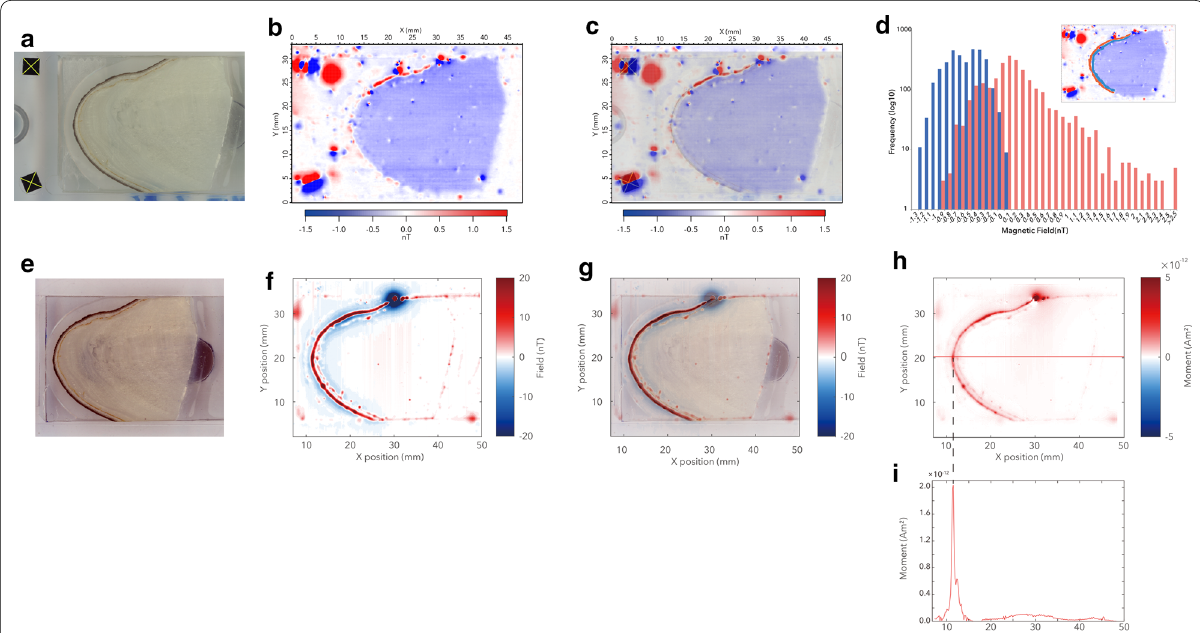
Fig. 2 Optical and magnetic images of NRM and IRM and their analyses. a Optical image, b magnetic image of NRM, and c optical image overlaid on the magnetic image of NRM. d Distribution of magnetic field within the highly magnetic layer next to the surface and the layer slightly inside with less magnetic feature. Each dataset was selected according to the region shown in the inset figure on the upper-right; i.e., red and blue correspond to the magnetic and less magnetic areas, respectively. e Optical image (contrast has been changed from a for better visibility of the colored surface layers), f magnetic image of IRM (1.4 T), and g optical image overlaid on a magnetic image of IRM (1.4 T). h Magnetic moment distribution of IRM image calculated on 0.2 mm 0.2 mm grid points from the magnetic field in f . Magnetic moment distributions were calculated, × according to Weiss et al. (2007). i Line profile along a horizontal line in h at 20.1 mm of Y position. The range of gray shade is the same as the range of a light green square in